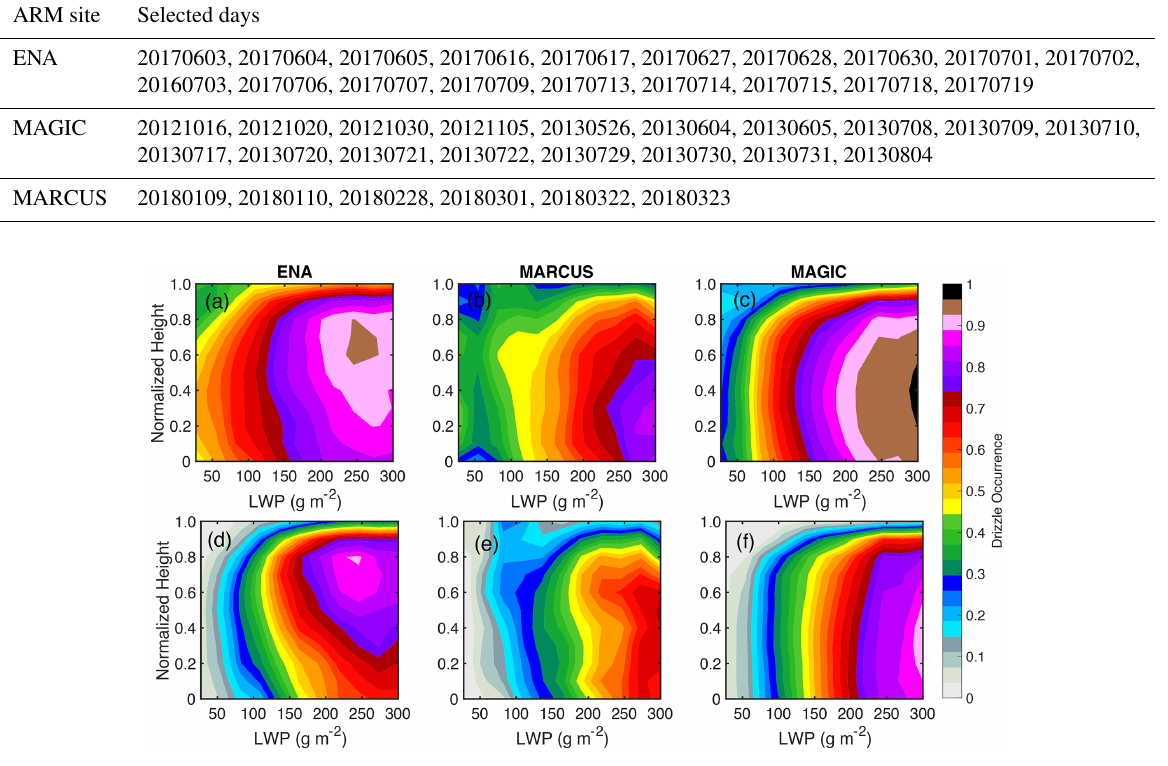
Figure 5. Vertical distribution of drizzle occurrence categorized by LWP based on MLA in the ENA (a) , MARCUS (b) and MAGIC (c) observational campaigns. Panels (d) , (e) and (f) are the same as panels (a) , (b) and (c) except that the drizzle is detected by